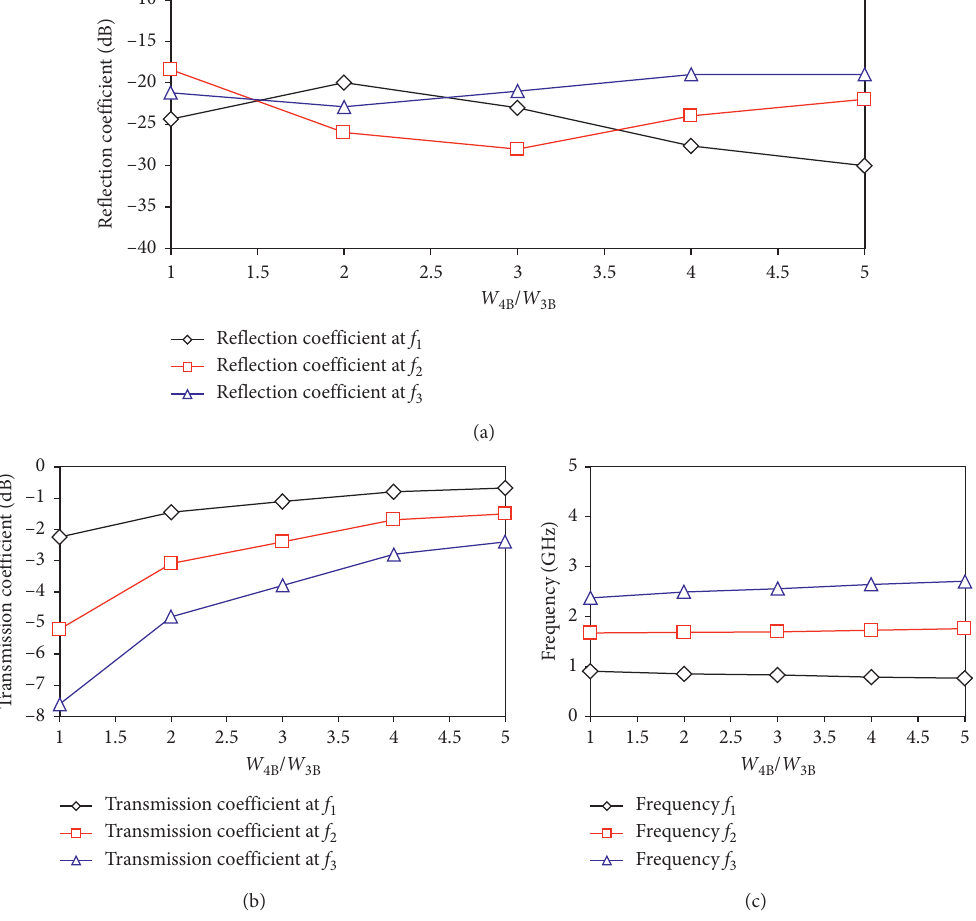
Figure 6: (a) The extracted reflection coefficients, (b) extracted transmission coefficients, and (c) extracted resonant frequencies of an MW- BPF using a QC-SSIR with varied W 4B / W 3B values.